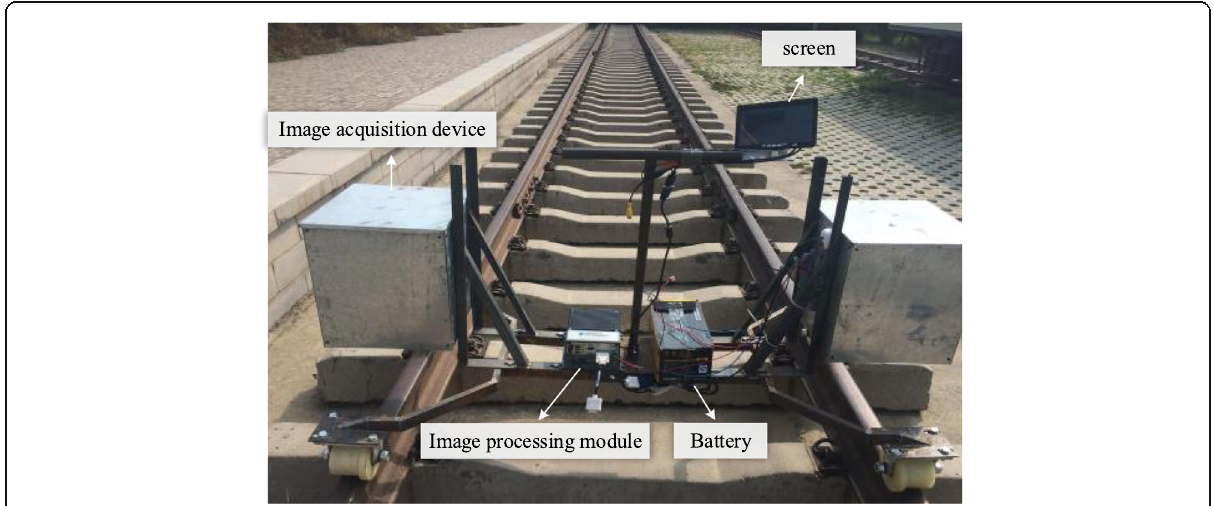
Fig. 10 Prototype of track defect detection